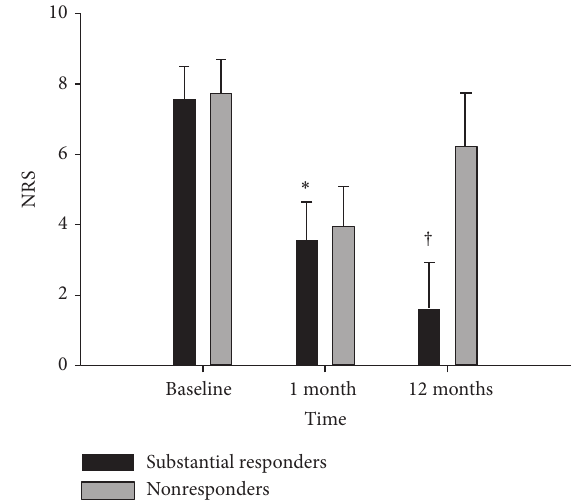
Figure 3: Change in numerical rating scale (NRS) pain scores between the substantial responder and nonresponder groups during follow-up; ∗ 𝑃 = 0.007 , † 𝑃 < 0.001 .